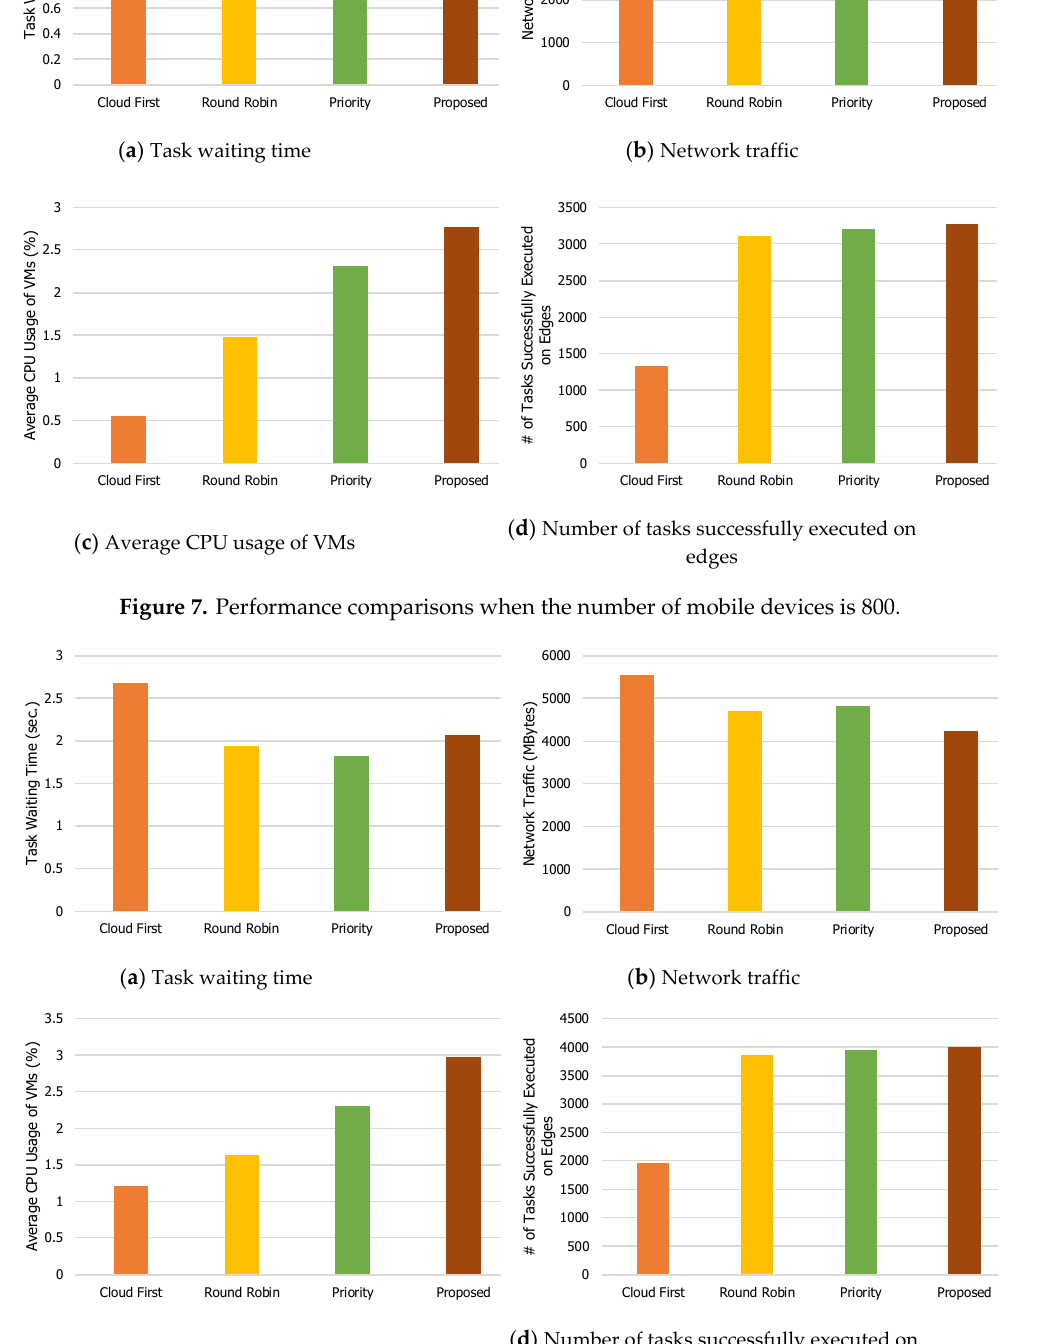
Figure 8. Performance comparisons when the number of mobile devices is 1000.